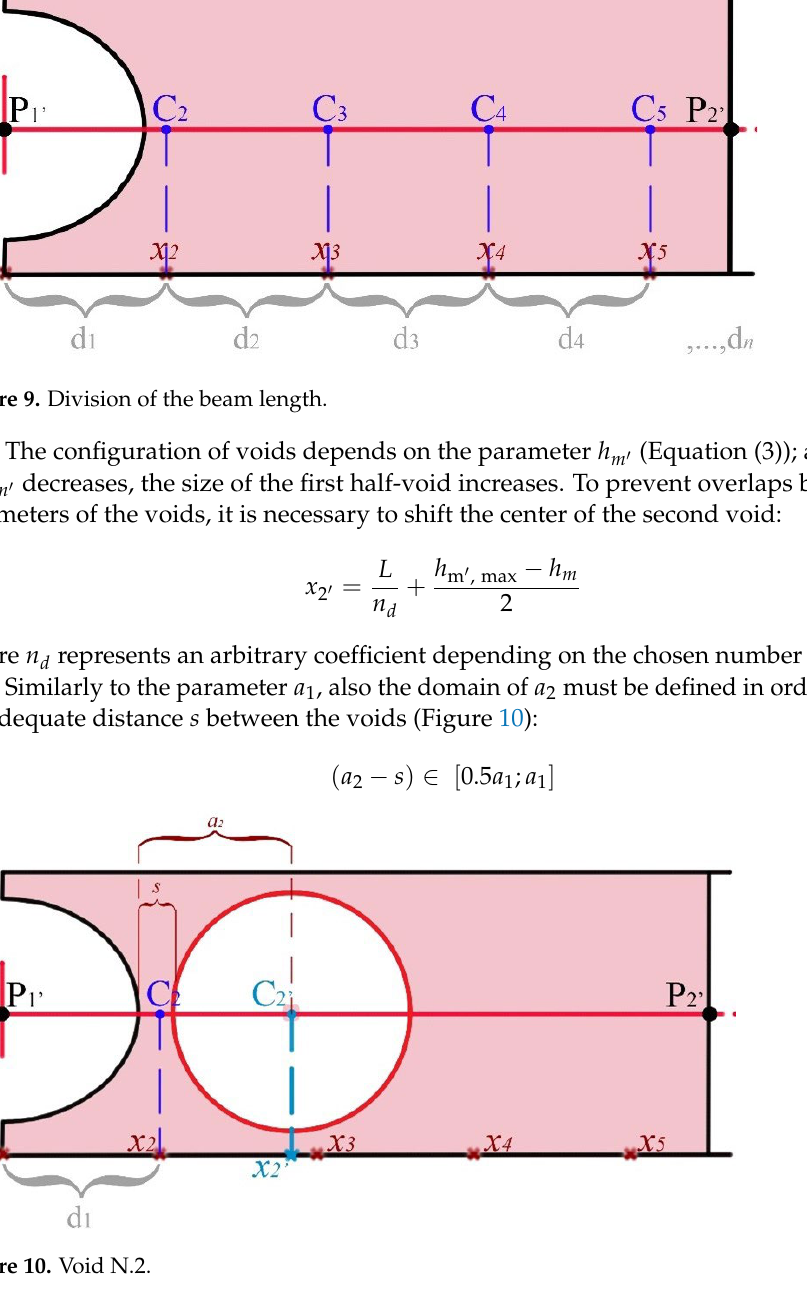
Figure 11. Void N.3. In the examined case, the use of inclined uprights could provide a better distribution of stresses. Therefore, if the optimal solution contemplates ellipses, it is assumed that they can rotate around their center, counterclockwise, by an angle in the range of 0°–45° (if 𝑎𝑎 𝑚𝑚 ≠ 𝑏𝑏 𝑚𝑚 ) (Figure 12).